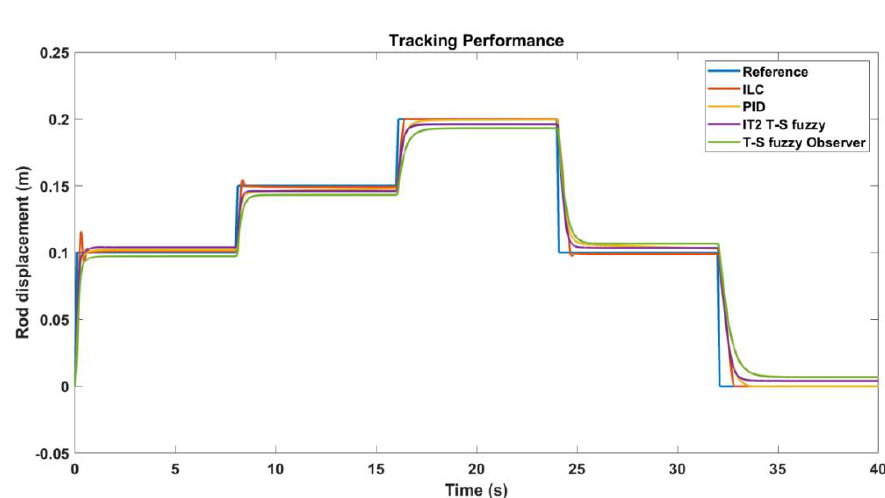
Figure 13. The comparison of the controllers’ performance in tracking a reference signal. Table 2. Comparison between the controllers’ performance in tracking a